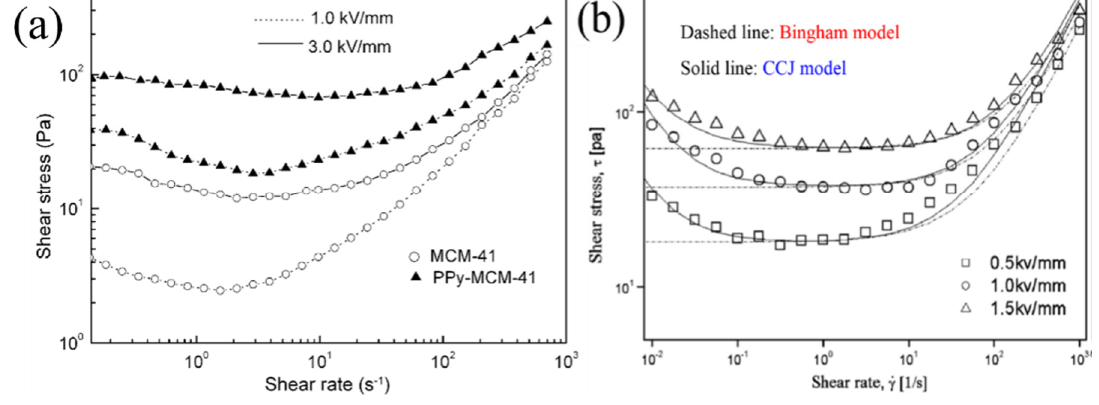
Figure 6. ( a ) Shear stress curve as a function of the shear rate for PPy/MCM-41 ER fluids (triangle) and MCM-41-based ER fluid (circle) under different applied electric fields. (Reproduced with permission from [78]. Copyright Elsevier, 2006); ( b ) Fitting curve of the model equations to shear stress curves for PPy/MCM-41 nanocomposite-based ER fluids under three different electric field strengths (Reproduced with permission from